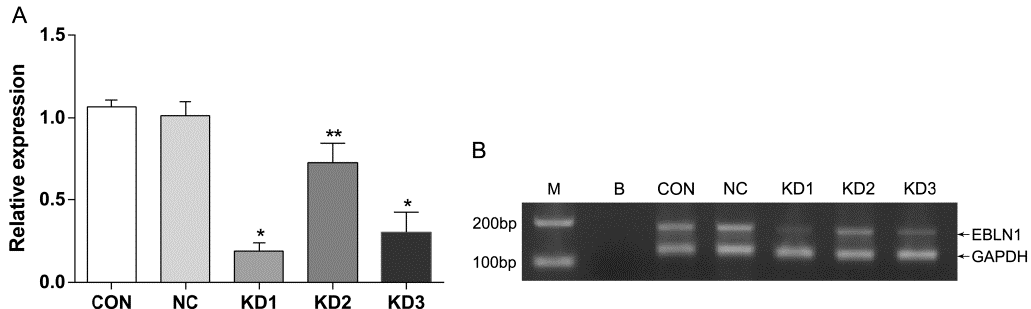
Figure 2. Determining the RNA interference efficiency of the LV (lentivirus)-EBLN1-shRNA vector in Figure 1. Examination of lentivirus infection efficiencies in oligodendroglia (OL) cells by fluorescence microscopy at 72 h post-infection (100×).